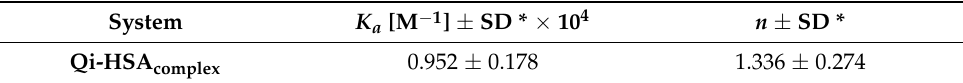
Table 2. The association constant ( K a ) and the number of molecules bound to protein ( n ) in Qi-HSA system; Qi:HSA molar ratio from 0.67:1 to 6.67:1; [HSA] 3 × 10 − 6 M; [Qi] 1 × 10 − 3 M; pH =